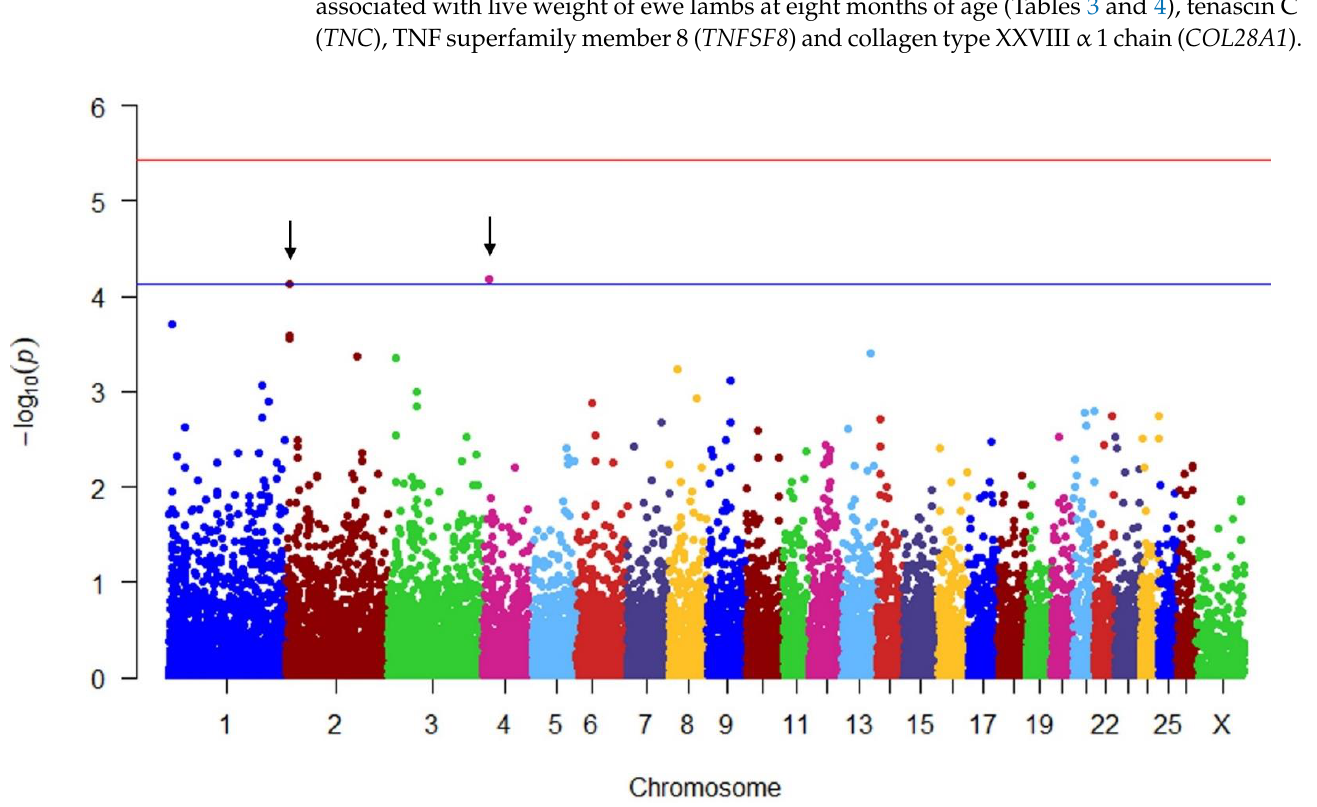
Figure 1. Manhattan plot showing the genome-wide association for live weight at breeding at eight months of age in ewe lambs. The red line includes the Bonferroni-adjusted genome-wide significant level at −log 10 ( p value) = 5.43, and the blue line includes the suggestive association significant level at −log 10 ( p value) = 4.12. Black arrows indicate significant single-nucleotide polymorphisms.